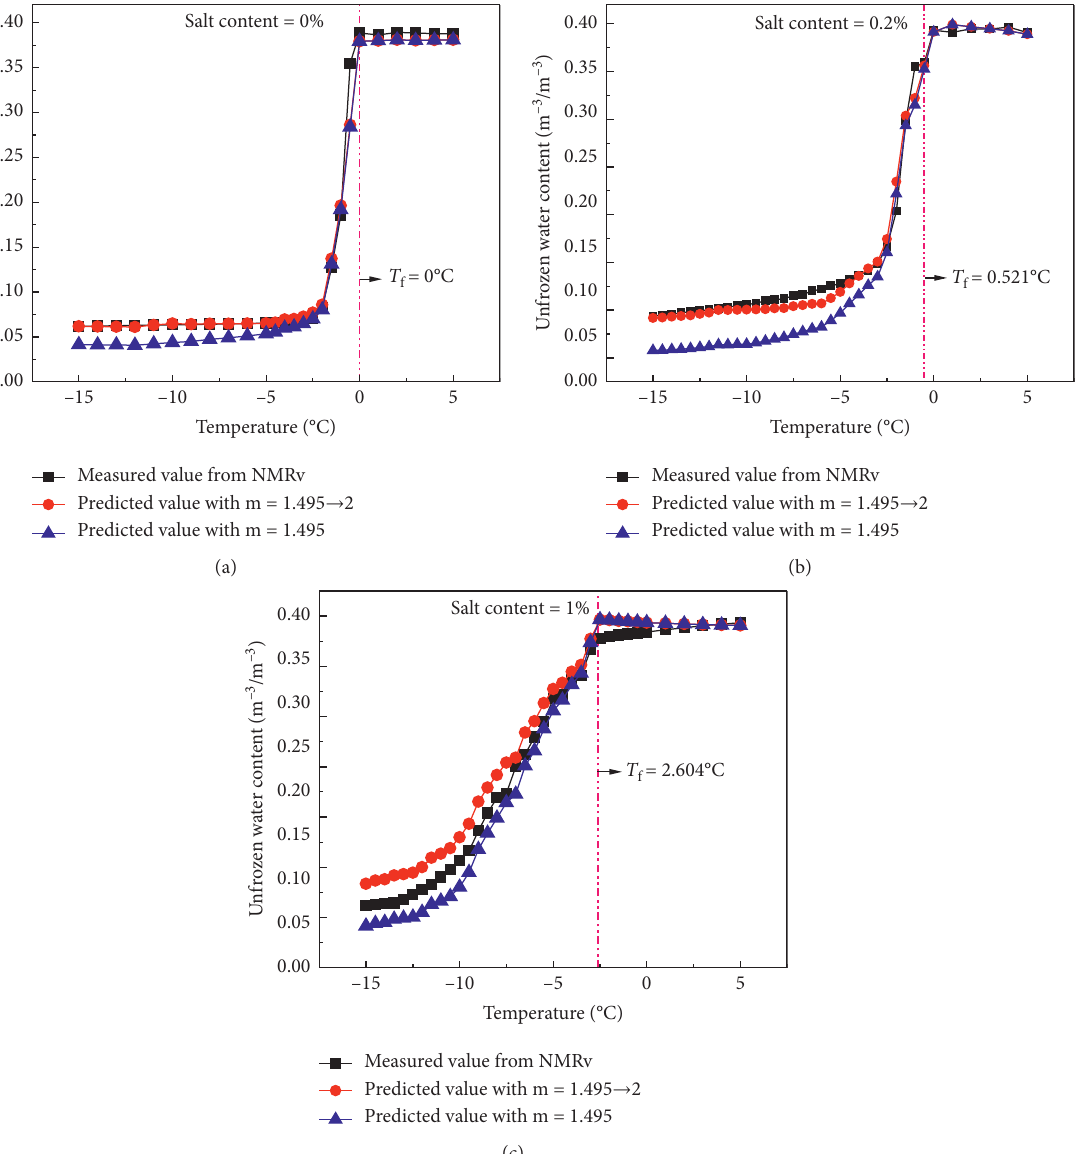
Figure 7: Comparisons between measured and predicted unfrozen water contents. (a) Without salinity. (b) Salinity of 0.2%. (c) Salinity of